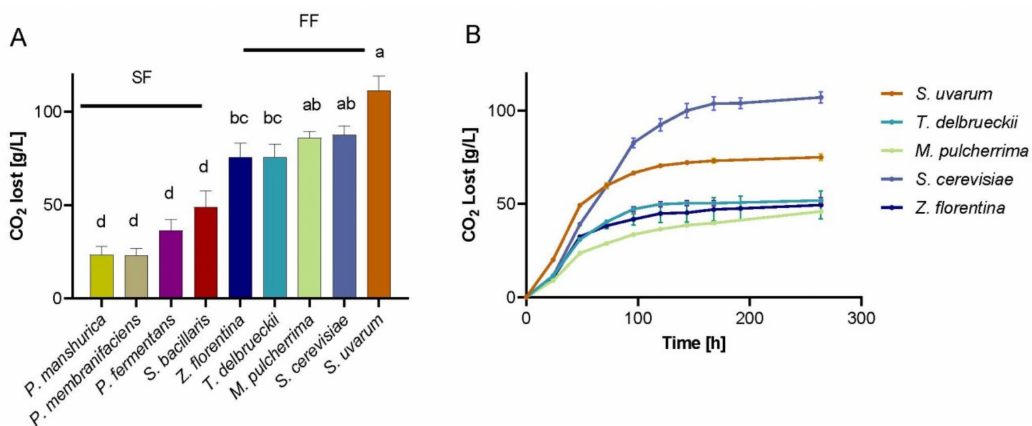
Figure 4. Fermentative capacity of natural strains. ( A ) Total CO 2 lost in all strains in 10 mL fermentations (SF, Slow Fermenters and FF, Fast Fermenters), a,b,c,d,e depict significant di ff erences (p-value < 0.05, ANOVA). ( B ) FF under 50 mL fermentations with agitation. EC1118 was used as the commercial S. cerevisiae